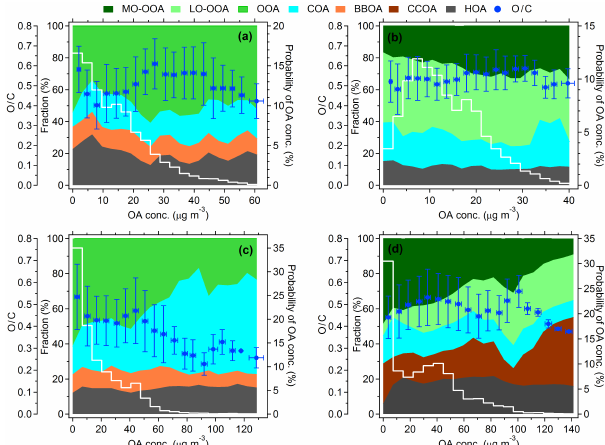
Figure 7. Fractions of OA components at different OA concentra- tion levels and the probability distributions of OA concentrations (white curves) during the spring (a) , summer (b) , autumn (c) , and winter (d) observations. The average O / C ratios in each segment are illustrated and the error bars in the x - and y -axis were the stan- dard deviations of OA concentration and O / C ratios,